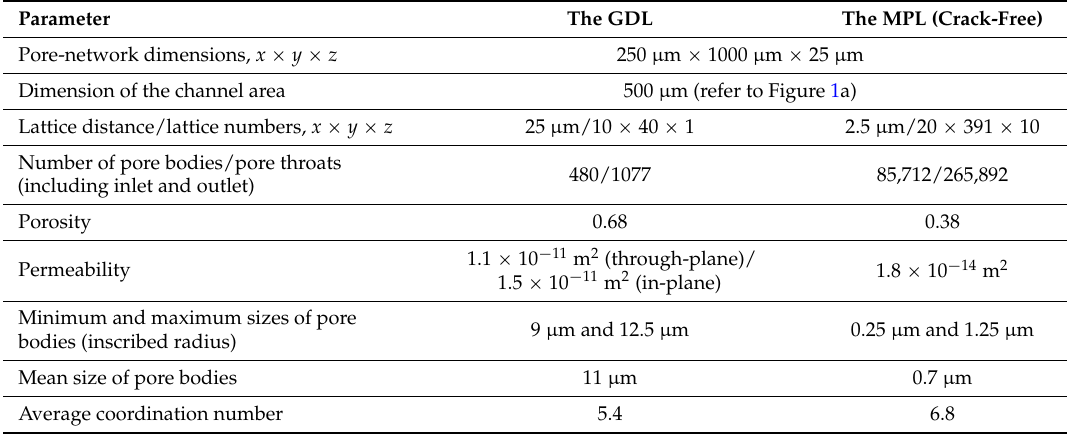
Figure 2. Pore-size distributions of the GDL and MPL networks. Table 1. Information of the generated pore networks for the uncompressed carbon-paper GDL and MPL.